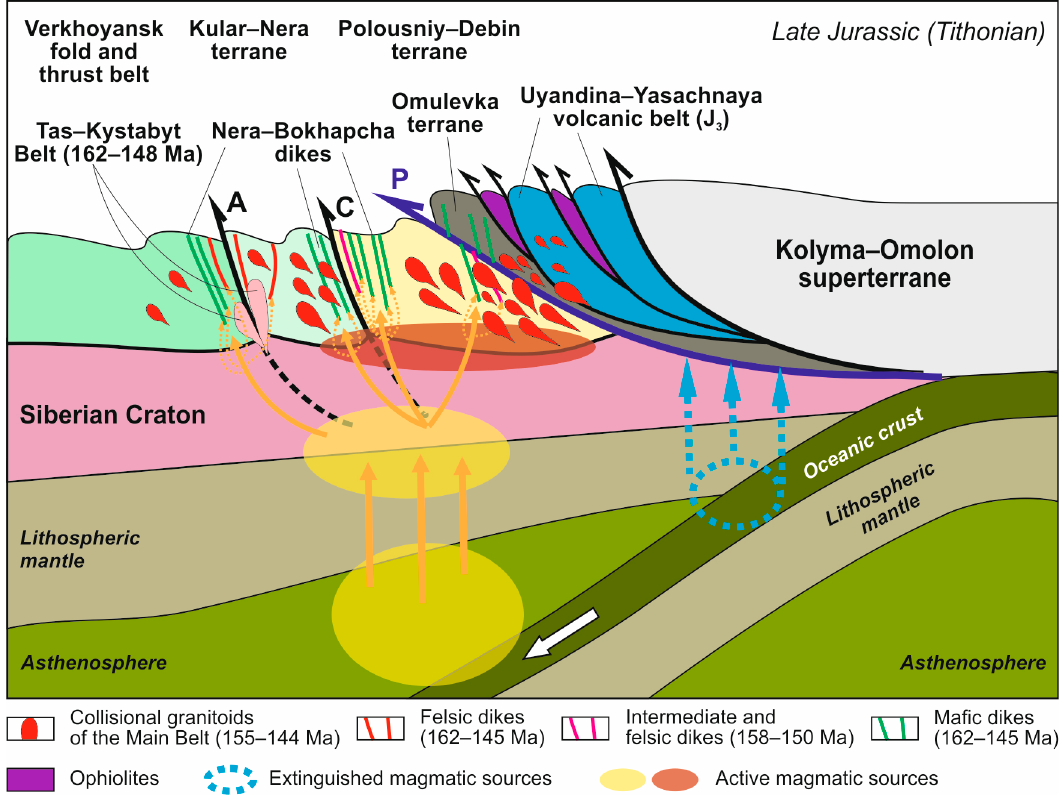
Figure 9. Model section through the northeastern margin of Siberia for the latest Jurassic (Tithonian).